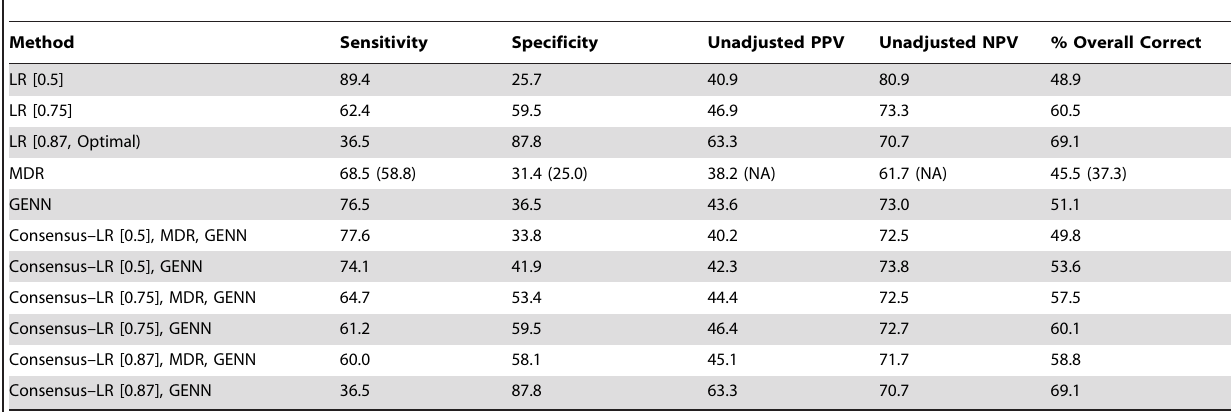
Table 6. Classification rates using the VM training dataset for training and the ARMA dataset for testing.